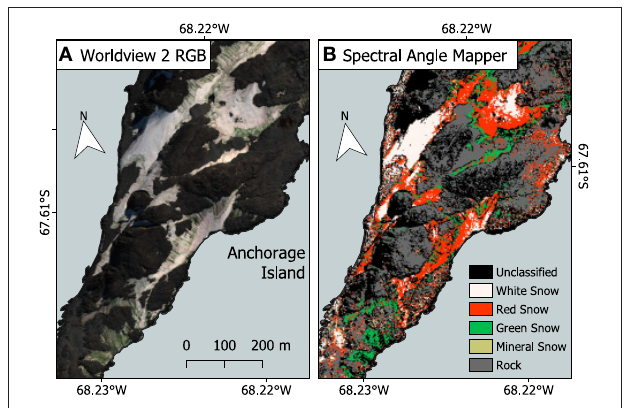
FIGURE 8 | Spectral angle mapper (SAM) classification example. (A) Red–green–blue (RGB) true color WorldView 2 image of a section of Anchorage Island from February 28, 2017. Image extent is highlighted in Figure 1 . (B) Output from the spectral angle mapper classification (SAM), used to determine which pixels contained red, and green snow algae for later calculation of pixel cell density.